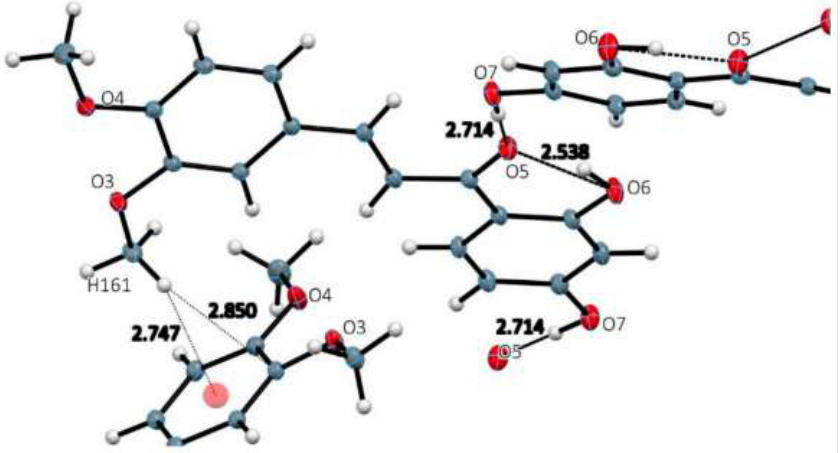
Figure 4. Hydrogen bonding interactions in DHDM crystal structure. One intramolecular O6-H11 . . . O5 2.538 (1)Å and one intermolecular H-bond O7-H13 . . . O5 2.714 (1) Å. There is a methoxy H- π hydrogen bond C16-H161 . . . phenyl centroid 2.747 (1) Å; (methoxy C16-H161 . . . C3 2.850 (1)